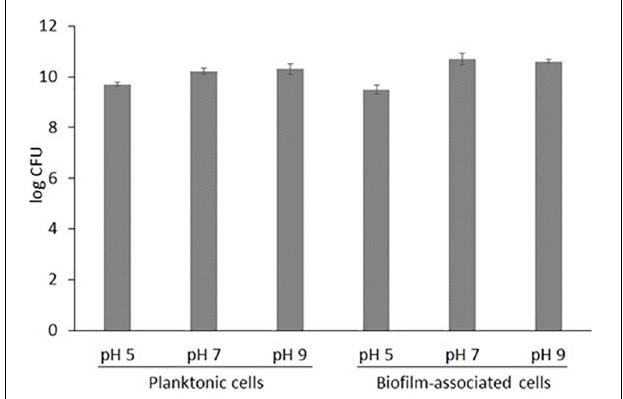
FIGURE 1 | Total growth of S. aureus COL in liquid TSB medium (log CFU in 10 mL) and nitrocellulose filters placed on solid TSA medium (log CFU per disk) ( n = 3, where n the number of biological replicates; ± STDEV error bars are also